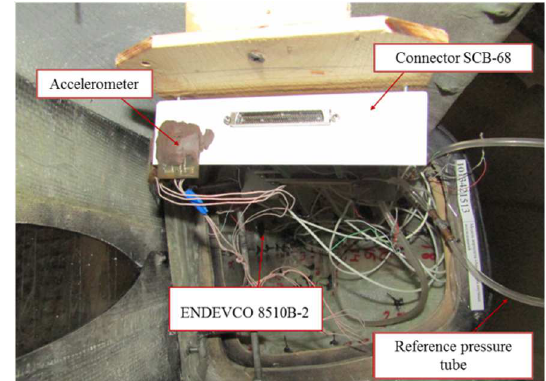
Fig. 4. Equipment inside the fuselage .